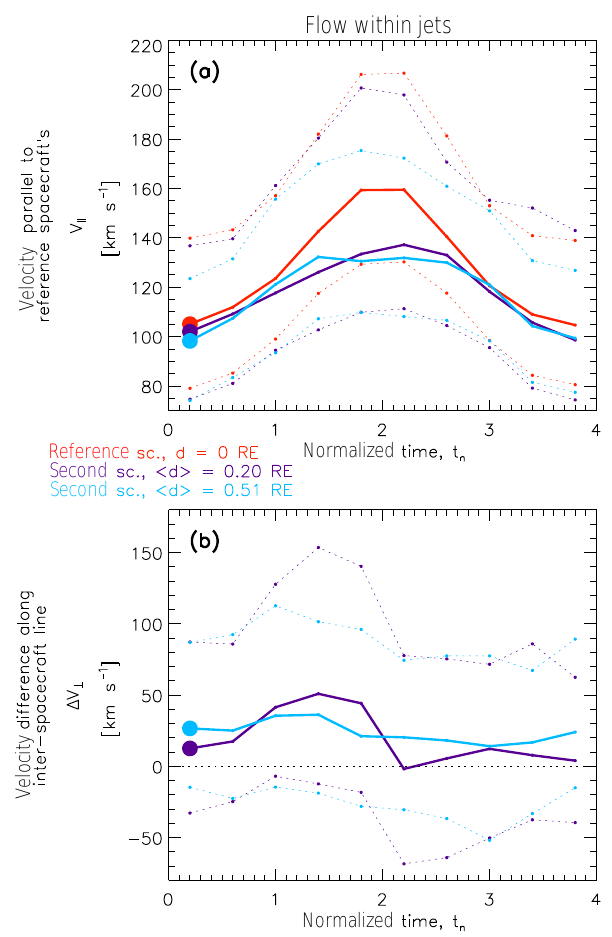
Figure 2. Cases where second spacecraft observed jets. The top panel (a) shows v (cid:107) and the bottom panel (b) shows (cid:49)v ⊥ values. Median and (upper and lower) quartile values are depicted with solid and dotted lines, respectively. Red lines correspond to ref- erence spacecraft measurements; purple and blue lines correspond to second spacecraft measurements for d < 0 . 4 R E ( (cid:104) d (cid:105) = 0 . 20 R E ) and d > 0 . 4 R E ( (cid:104) d (cid:105) = 0 . 51 R E ), respectively. Initial median values pertaining to normalized times t n = 0 ... 0 . 4 are depicted by bold cir-